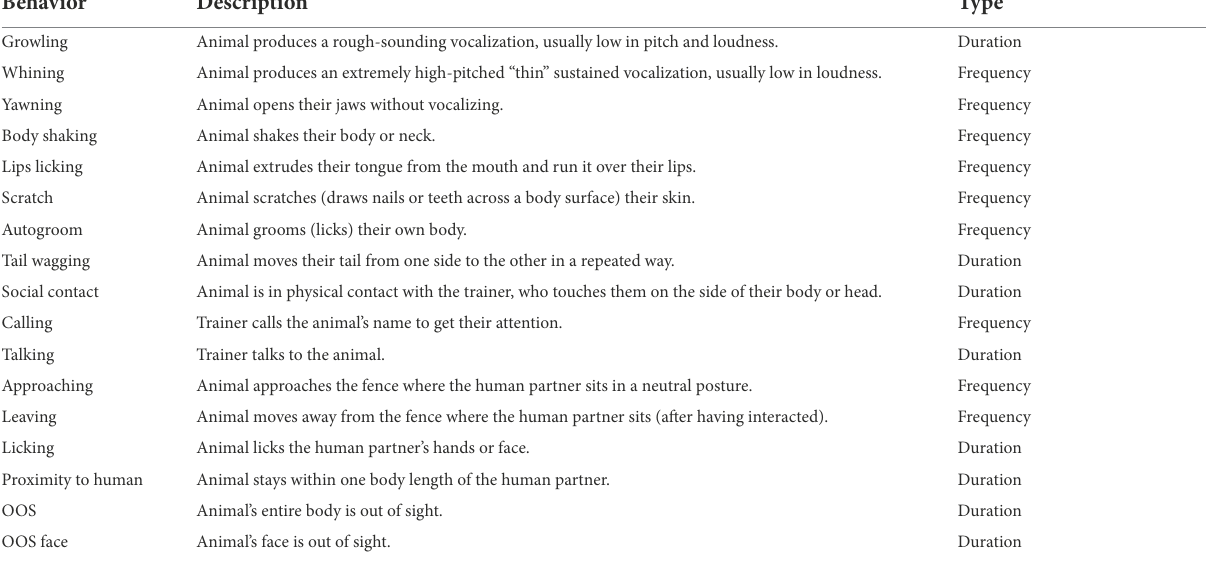
TABLE 3 Social interaction test ethogram.